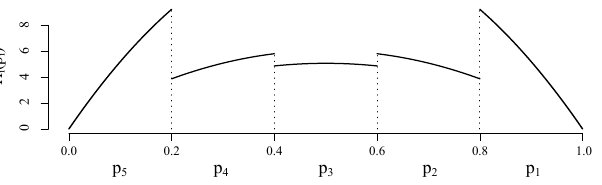
Figure 4. Prior distributions for probabilities p i ’s for a 5-hop opportunistic model considered for a MC simulation study.